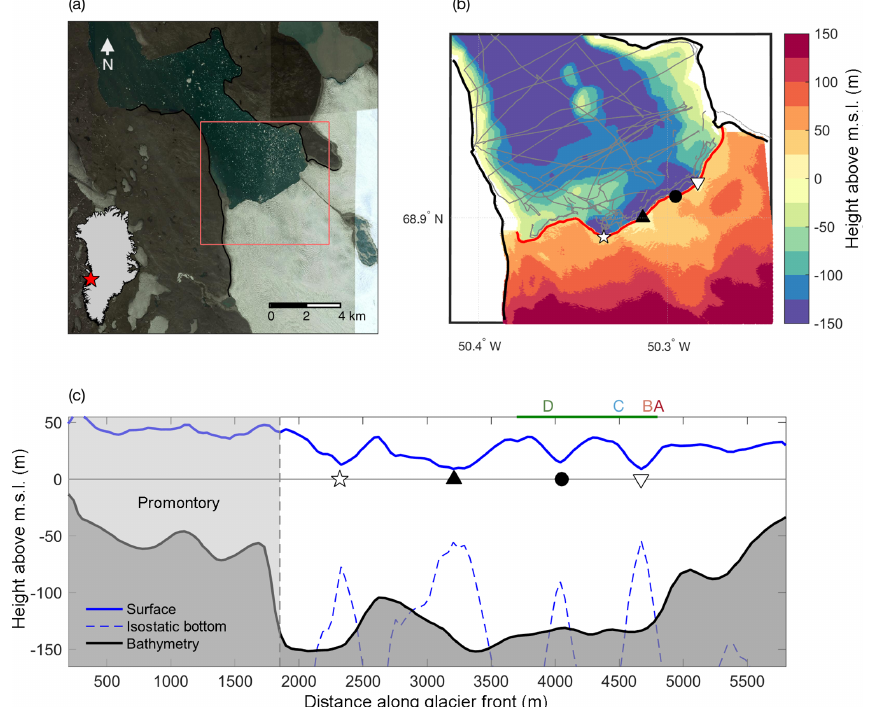
Figure 1. (a) Landsat 8 image of the lower part of Saqqarliup Sermia and Sarqardleq Fjord. The inset of Greenland shows the location of the glacier. (b) Gridded bathymetry from in situ observations (readings indicated by gray dots). Also shown is the surface height from ArcticDEM (digital elevation map created by the Polar Geospatial Center from DigitalGlobe, Inc. imagery). The red line shows the front position on 9 July 2013. (c) Surface height (blue) and bathymetry (black) along the glacier front (following the red line in b ). Also shown is the isostatic bottom of the ice (blue dashed). Locations of the two main plumes are highlighted in (b, c) by and (cid:79) ; two additional surface dips are indicated by (cid:78) and • . The green horizontal line above panel (c) and the letters A–D indicate the locations of the front profiles shown in Fig.